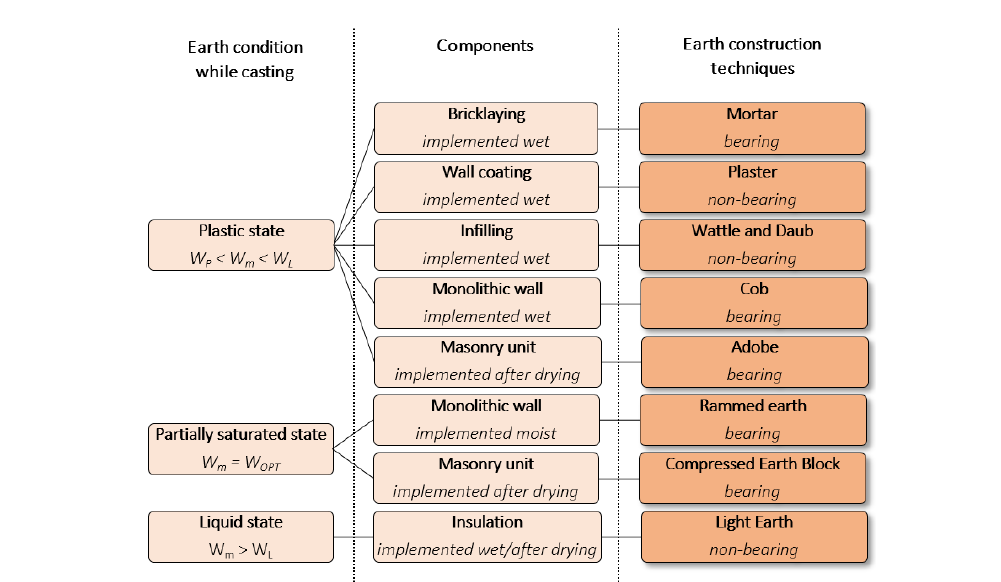
Figure 1. Earth construction processes classification, adapted after [1]. Where W m is the manufacturing water content, Wp and W L the water content of Atterberg limits, respectively the plasticity index and liquid limit, and W OPT the optimum water